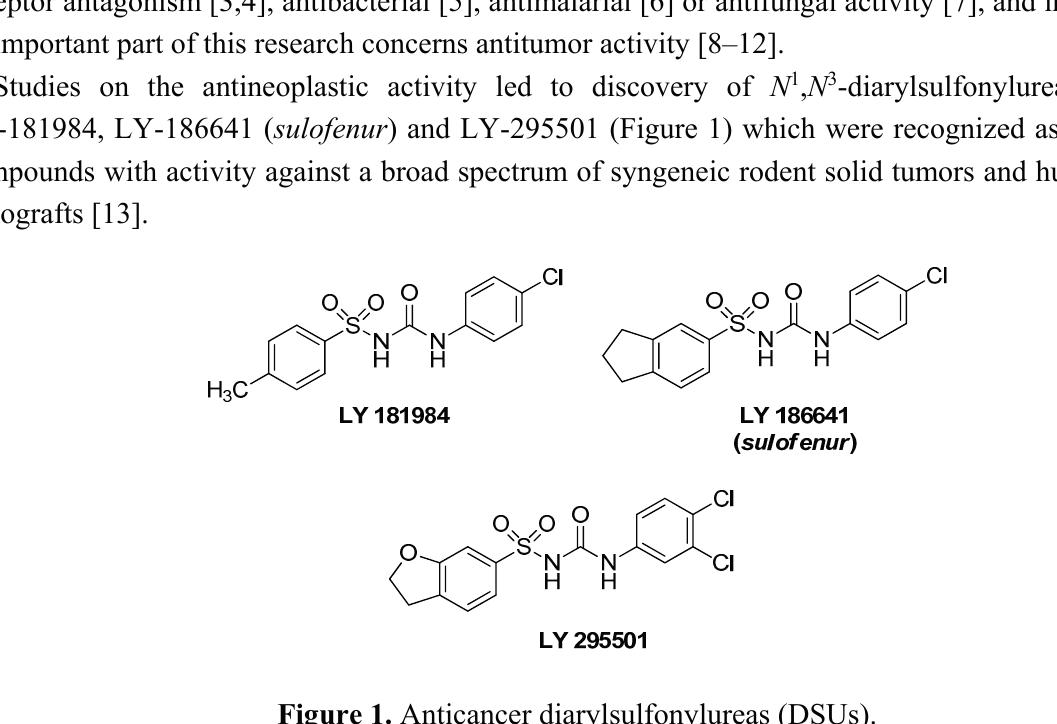
Figure 1. Anticancer diarylsulfonylureas (DSUs).